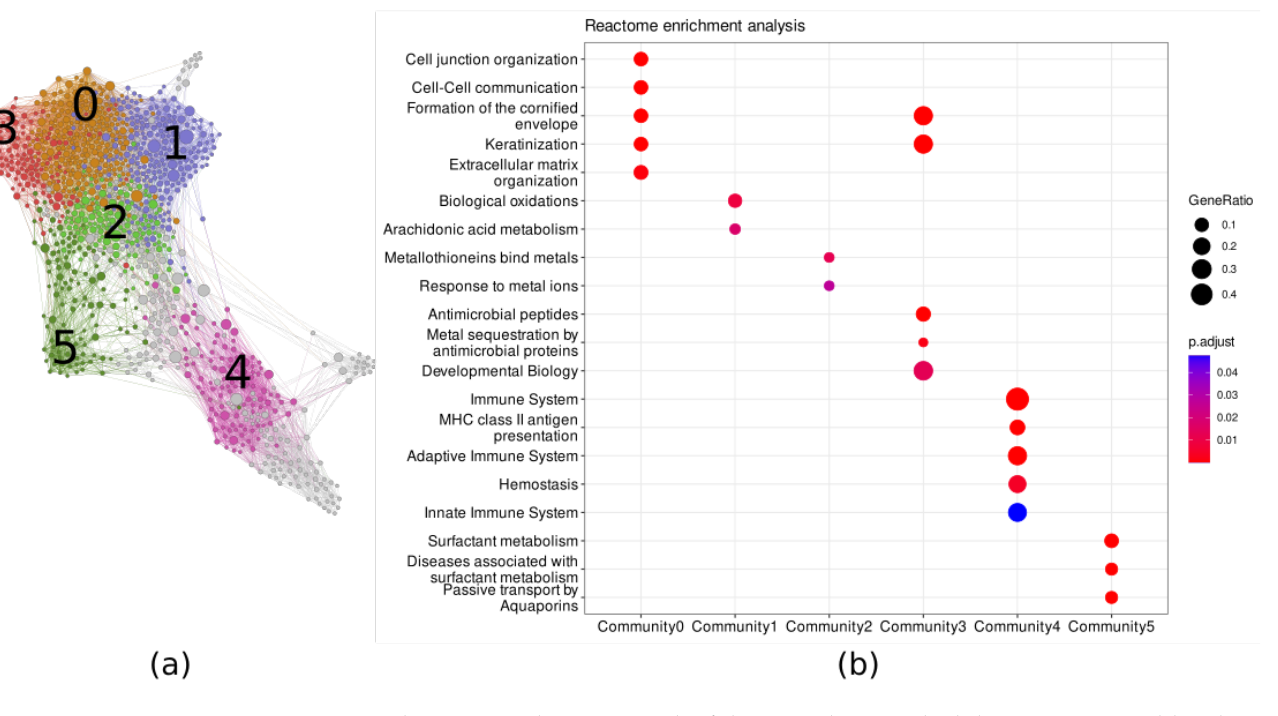
Figure 3. The gene regulation network of the DEGs between high keratinization and low keratinization samples. ( a ) The gene regulation network reconstructed by GRNBoost2 algorithm. Each community was labeled with its community number and different color. ( b ) The Reactome pathway- based enrichment analysis showed the functional classes of each community that connected to the keratinization process in LUSC.